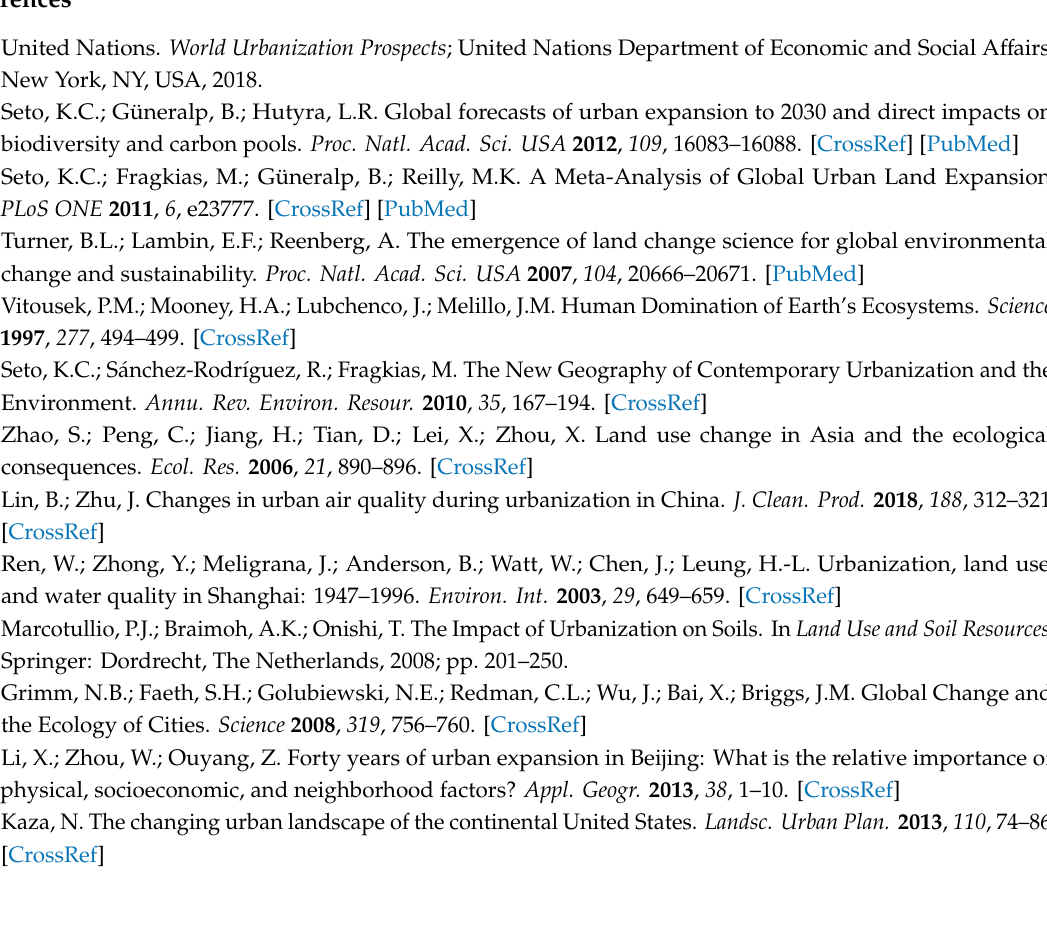
Table S1: The major policies in the GBA during 1979–2017, Table S2: The annual urban area of 11 cities in the GBA during 1986–2017, Table S3: The annual urban area, AI, and AGR of the GBA during 1986–2017; Figure S1: the changes of GDP and population of the 11 cities in the GBA during 1986–2017; Video S1: the annual urban expansion process of the GBA during